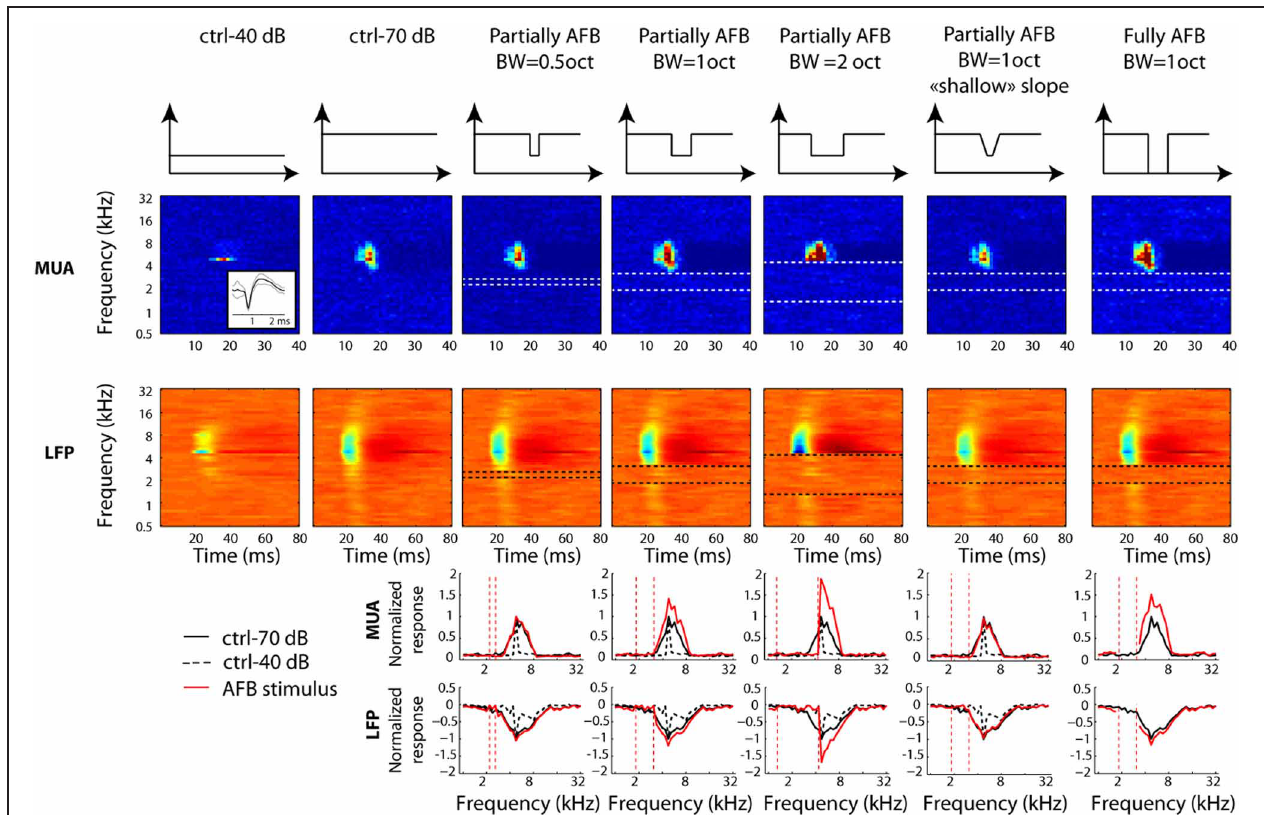
FIGURE 3 | Neural tuning of individual recordings obtained from one selected example at a given location in primary auditory cortex. Otherwise as Figure 2 . Note that the neural receptive field is unchanged when the notch is at remote